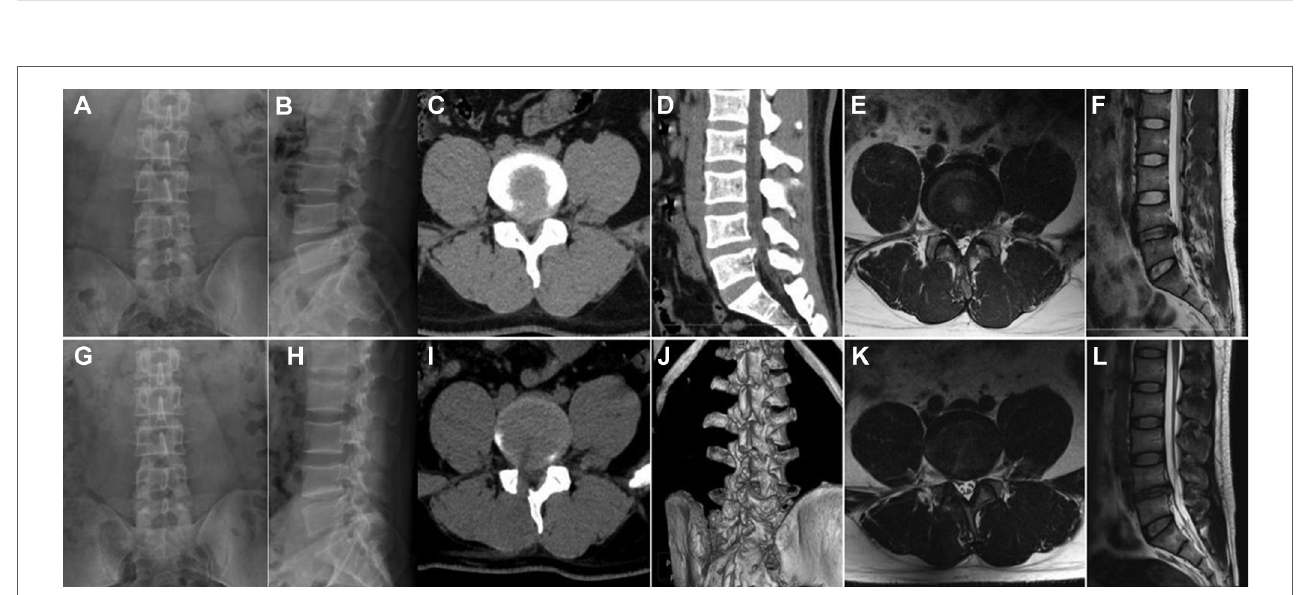
FIGURE 1 Intraoperative positioning and access establishment of UBE. ( A,B ) Body markers of L4/5 intervertebral space and the surgical approach. ( C,D ) The frontal and lateral view of the viewing and working portal.